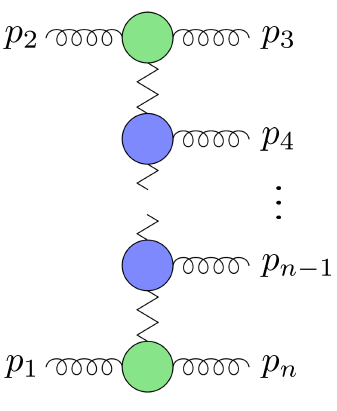
Figure 4 . The factorised structure of gluon amplitudes in MRK. The zigzag line represents the Reggeized gluon propagator given in eq. (2.4). The coloured blobs represent impact factors, and one-gluon CEVs. At LL accuracy these elements are only required at tree level, but much like the gluon Regge trajectory α ( t ) , they can be defined to all orders in perturbation theory (note that this interpretation departs from the previous figures where the blobs are specific to a given loop